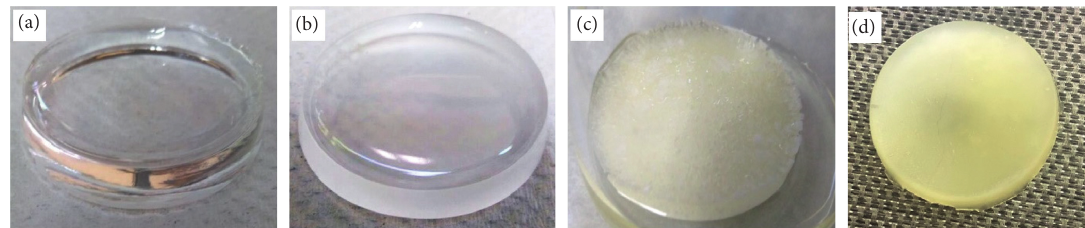
Figure 3: Hydrogel of PAAm/starch: (a) PAAm/starch 100/0; (b) PAAm/starch 50/50; (c) PAAm/starch 50/50 loaded with amoxicillin lyophilized; (d) PAAm/starch 50/50 after drug release in buffer solution (pH 3.0).